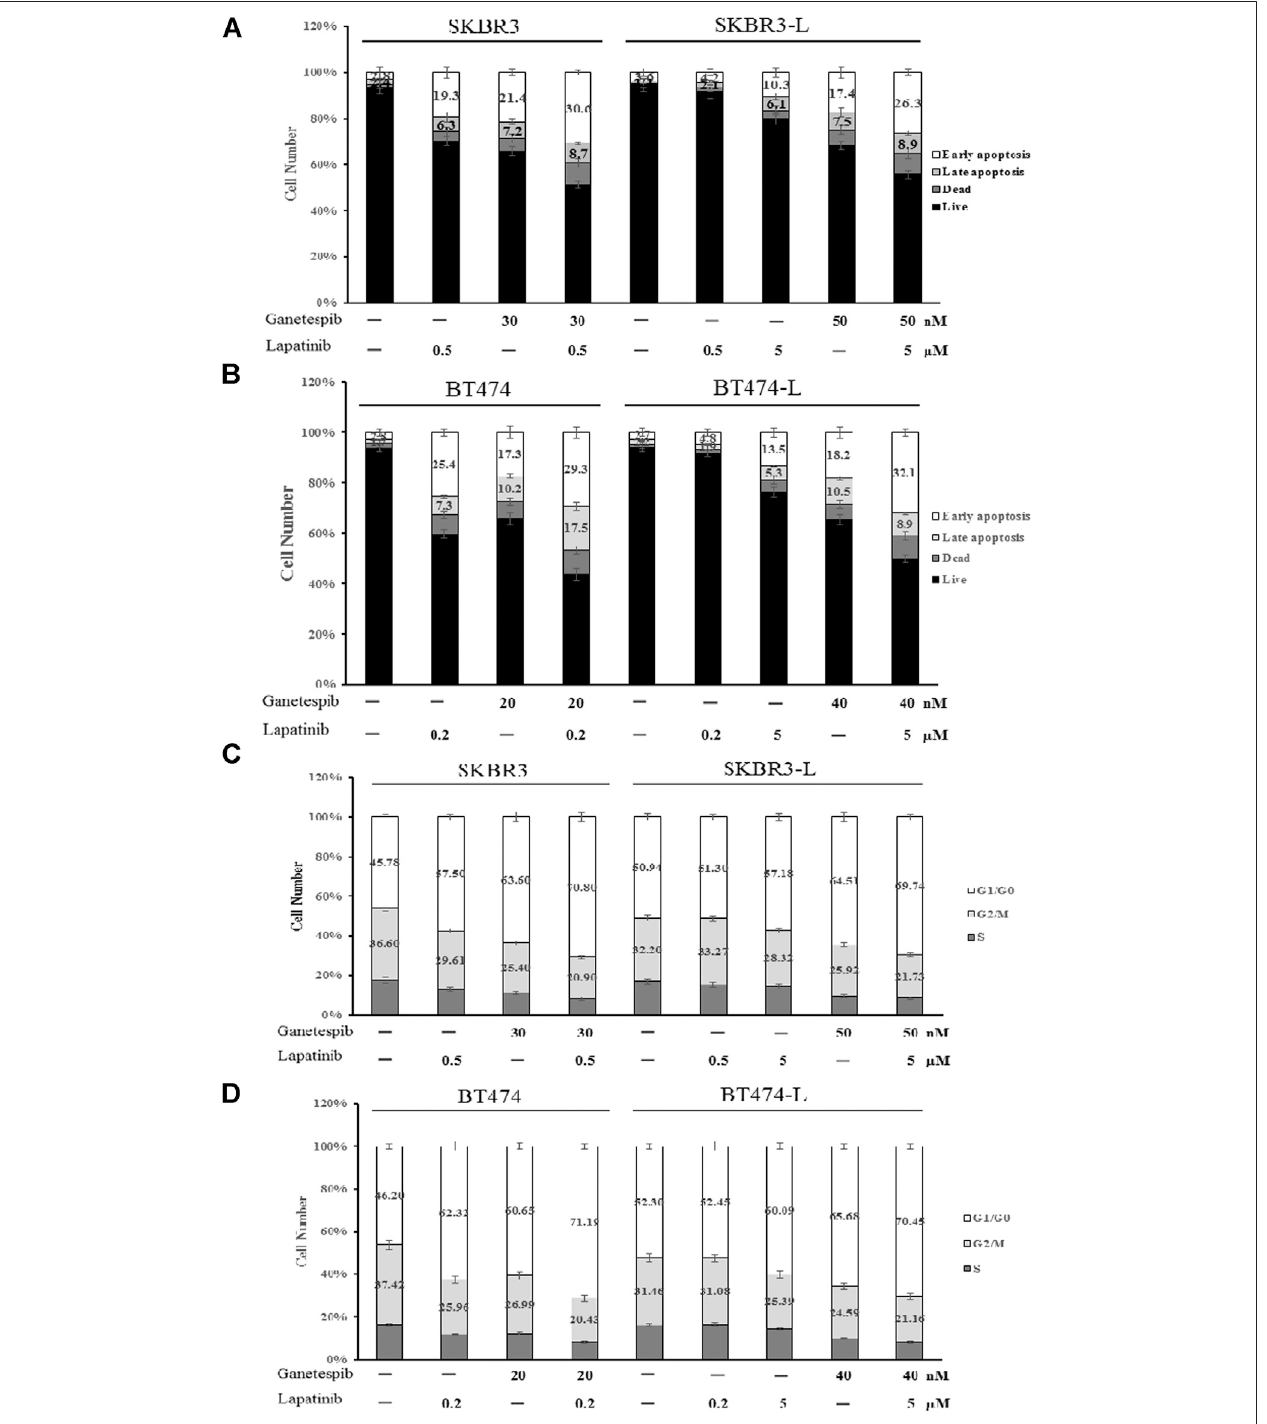
FIGURE 3 | Effect of ganetespib and lapatinib, alone or in combination, on cell cycle and apoptosis. (A) SKBR3, SKBR3-L, (B) BT474, and BT474-L cells were treated with ganetespib, lapatinib or combination for 24 h. Apoptotic cell death was detected by staining cells with Annexin-V: FITC Apoptosis Detection Kit before fl ow cytometry analysis. (C) SKBR3, SKBR3-L, (D) BT474, and BT474-L cells were treated with ganetespib and lapatinib, alone or in combination, for 24 h. The cells were then fi xed with 70% ethanol at – 20 ° C overnight, incubated with RNase A at 37 ° C for 30 min, stained with propidium iodide for 10 min, and analyzed via fl ow